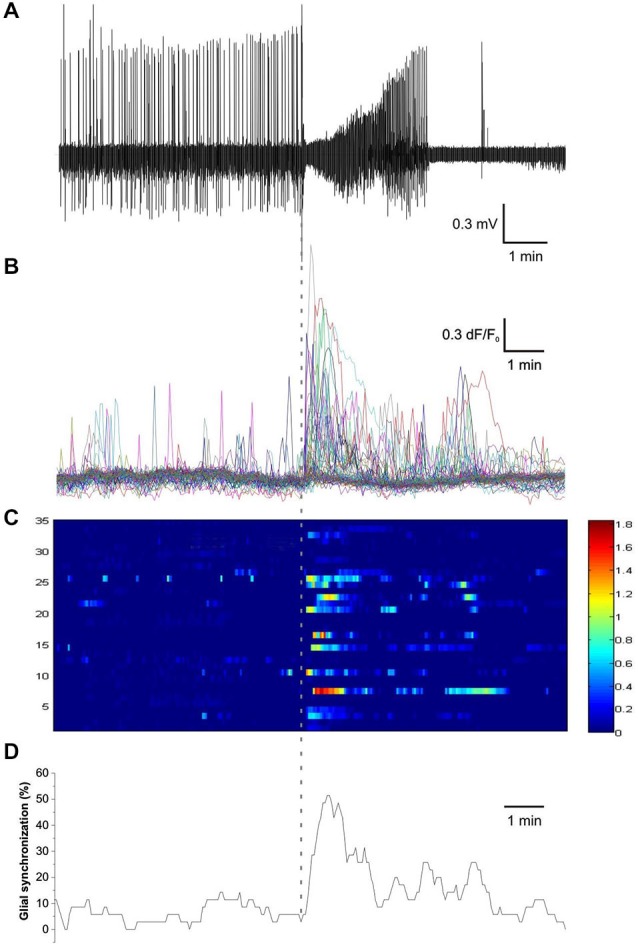
Astrocytes synchronize their activity after the initiation of seizure-like events. (A) Extracellular field potential recording of a seizure-like event (SLE) in the CA3 region in a hippocampal slice. (B) Ca2+ transients measured by Fluo-4 fluorescence in CA3 astrocytes during SLE. (C) Ca2+ transients in individual astrocytes. Each row represents a single astrocyte. (D) Percentage of astrocytes showing Ca2+ transients within a 10 s window. Vertical dashed line indicates the start of SLE.